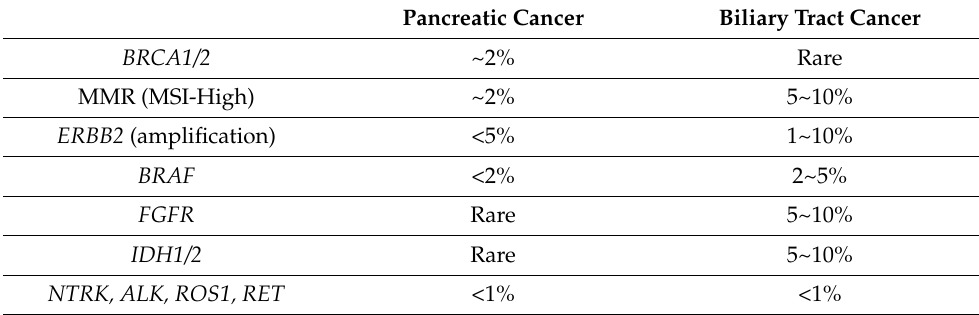
Table 1. Druggable mutation profiles of pancreatic cancer and biliary tract